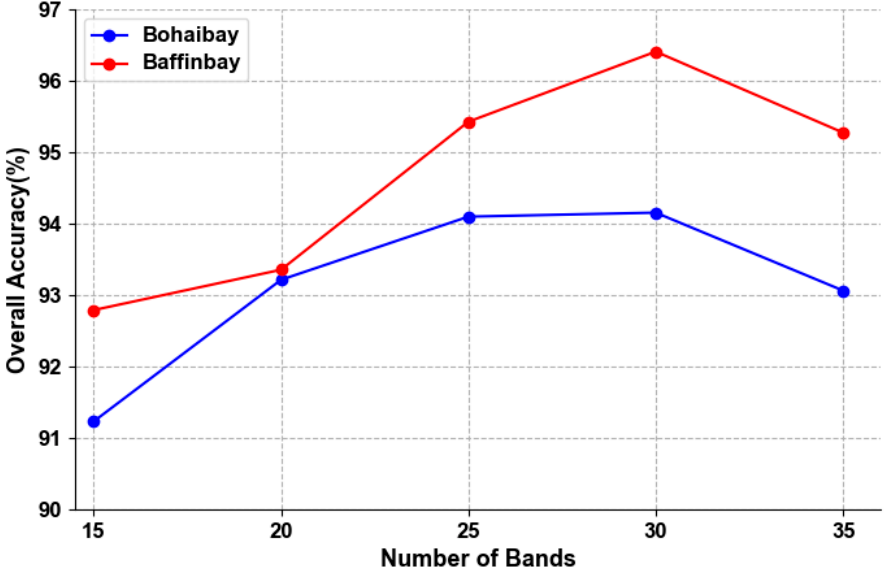
Figure 11. The influences of different numbers of bands on the classification accuracy.